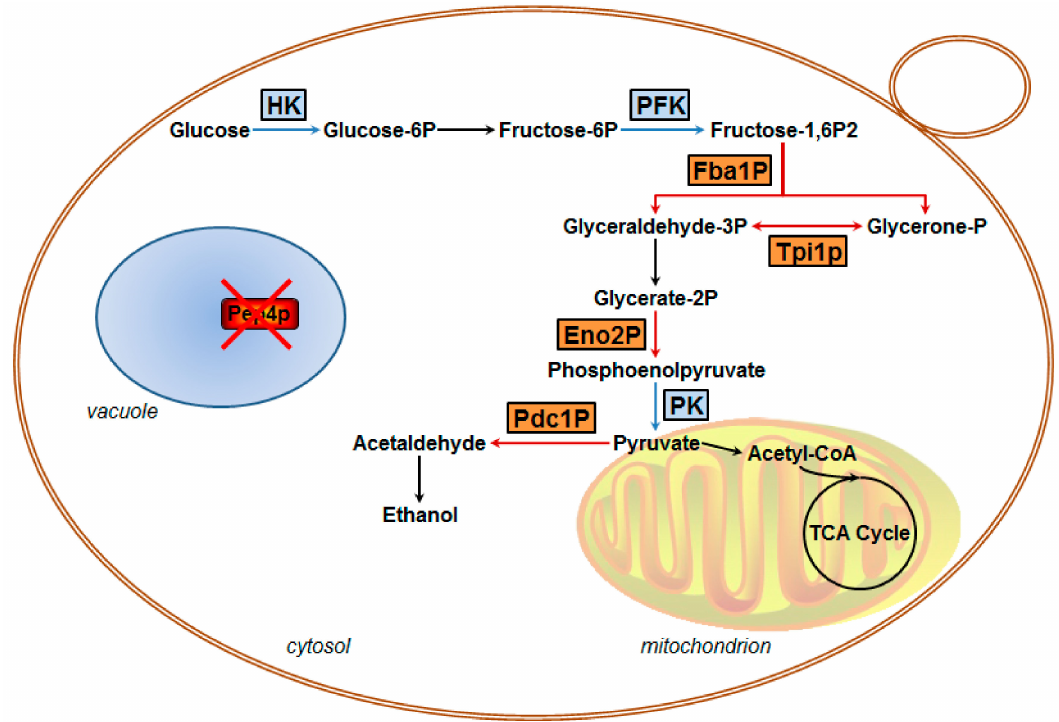
Figure 5. Putative overview of glycolytic metabolic processes in haploid S. cerevisiae regulated by vacuolar protease Pep4p based on proteomic analysis and RT-qPCR examination. Red cross represents Pep4p deletion. The blue frames show the proteins that participated in glycolysis in this work, while the orange frames show four identified down-regulated glycolytic enzymes involved in previous findings